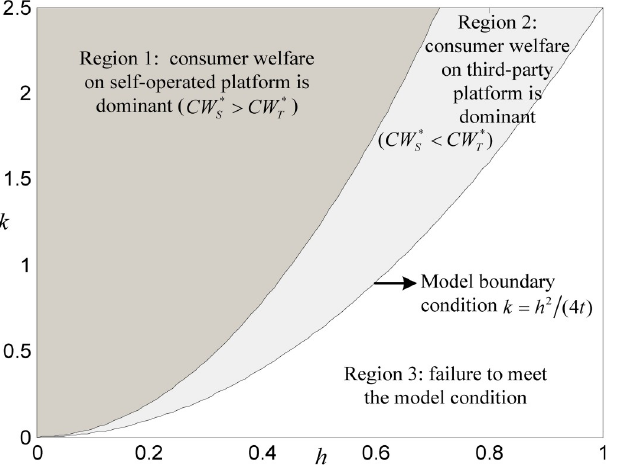
Fig 5. Comparison of consumer welfare between both